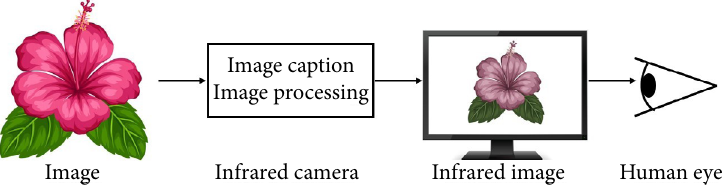
Figure 2. Image processing